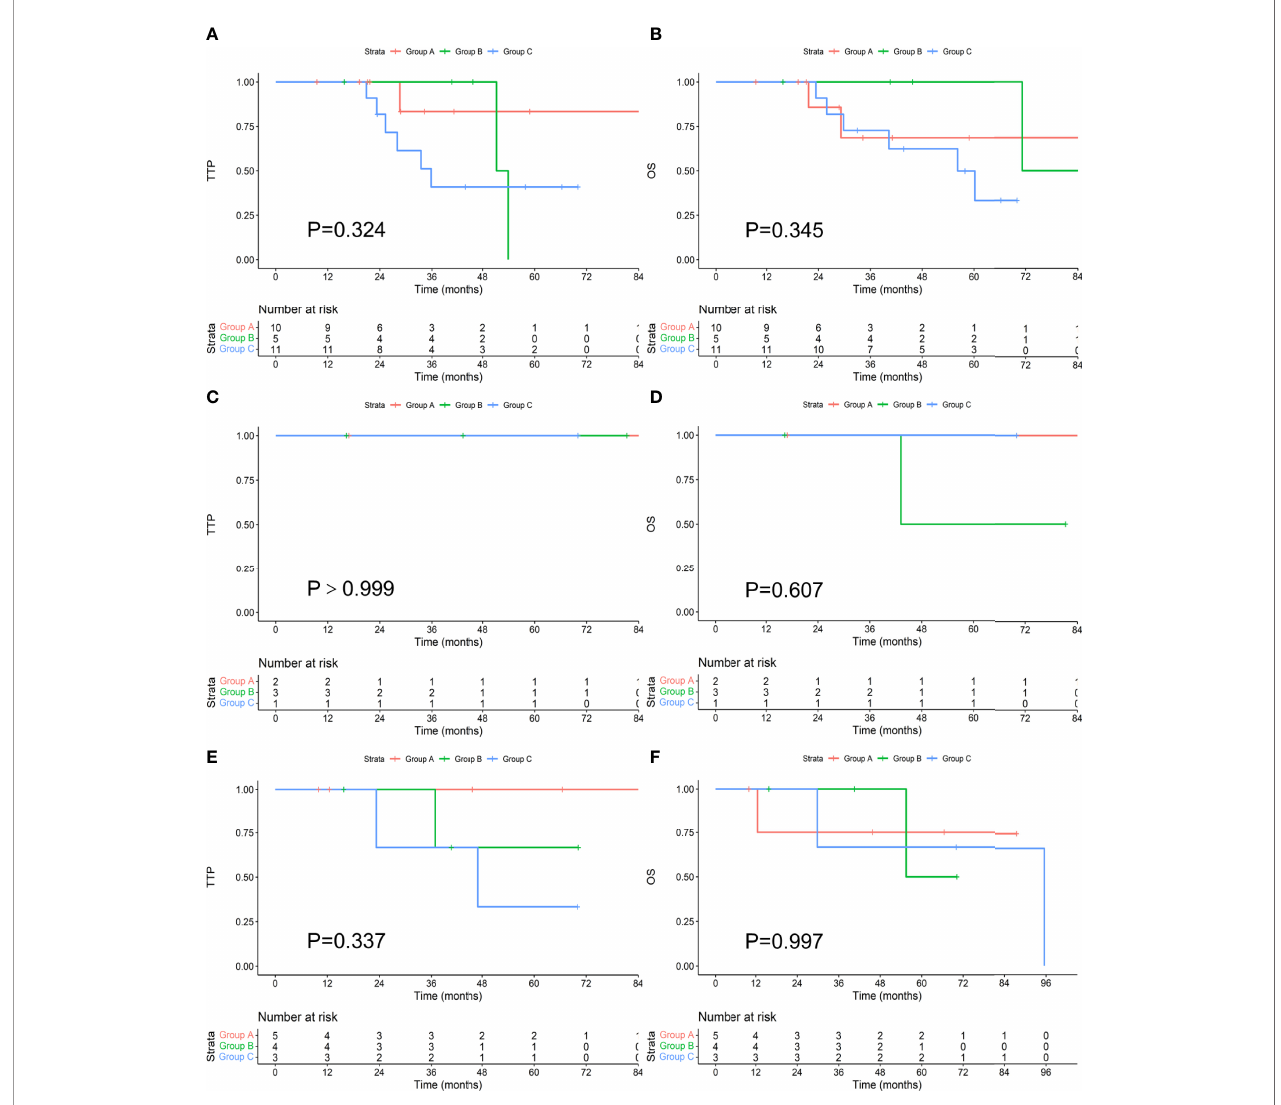
FIGURE 5 | Comparison of TTP (A, C, E) and OS (B, D, F) in patients with t(4;14), t(14;16), and 17p- who achieved an MRD-negative status at